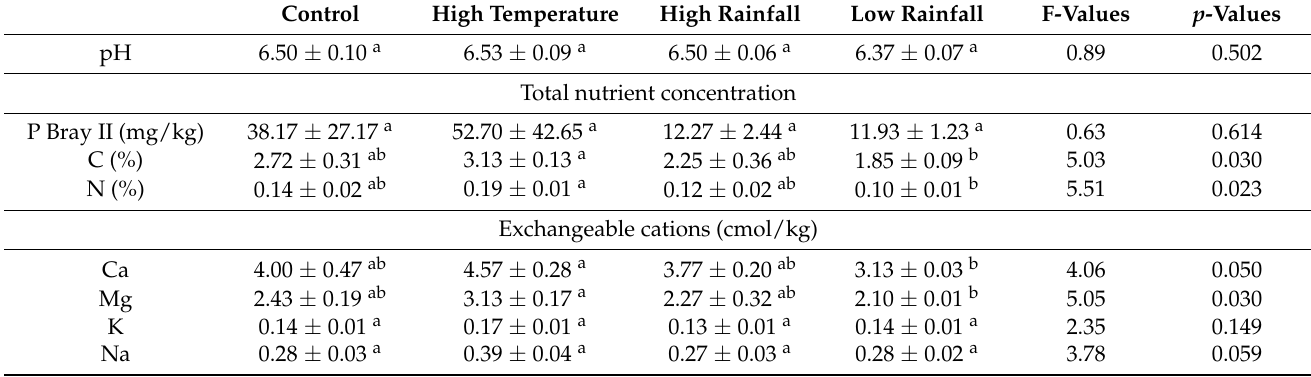
Table 1. Effects of elevated temperature and high and low rainfall on soil properties after Acacia mearnsii seedling growth. Data are means ± SE and one-way ANOVA results are shown. Means with different superscript letters show significant differences ( p ≤ 0.05) among treatments. Values within columns with different letter superscripts are significantly different.